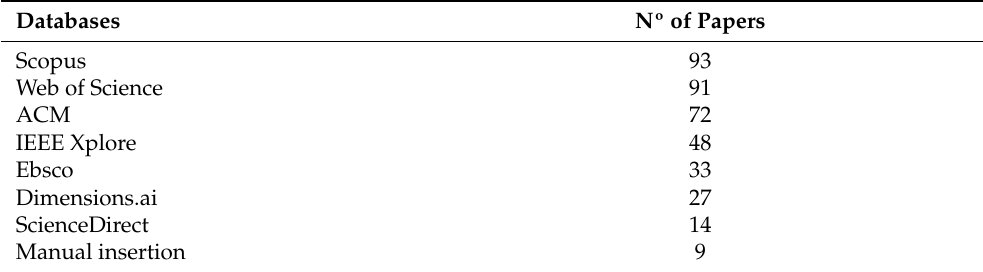
Table 5. Number of papers found per database.